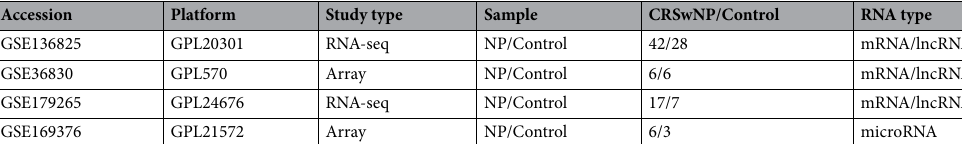
Table 1. Details for GEO CRSwNP Data. CRSwNP chronic rhinosinusitis with nasal polyps; NP nasal polyp; GEO Gene Expression